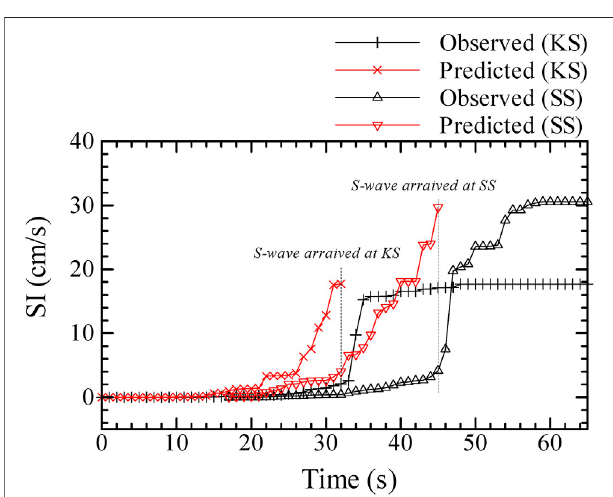
FIGURE14| PredictedSIofS-waveandobservedSIofS-wavewiththe time interval of one second during the 2011 off the Paci fi c coast of Tohoku earthquake ( Mw 9.0) at KS and SS stations. Predicted SI of S-wave by using P-wave in the real-time, is shown until the time that S-wave arrived at each KS and SS